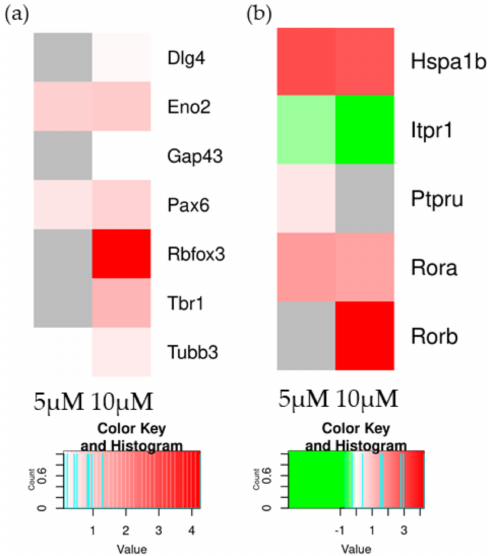
Figure 4. Heatmap of DEGs associated with neurodifferentiation ( a ) and genes involved in the activations of RORs ( b ) in the comparison of CTRL vs. 5 µ M (left column of each comparison) or CTRL vs. 10 µ M (right column of each comparison). The green scale is related to downregulated genes, whereas the red palette represents upregulated ones. Gray is used when the difference is not statistically relevant in the